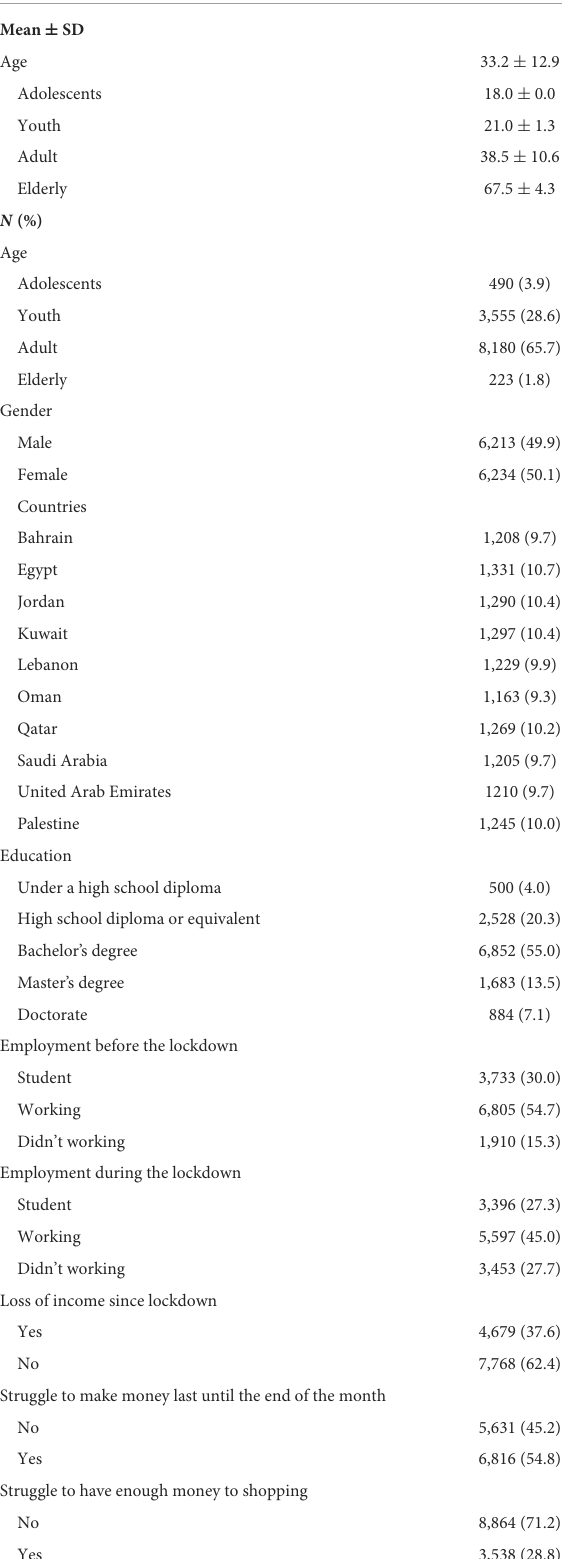
TABLE 1 Sociodemographic and socioeconomic characteristics of the study population.